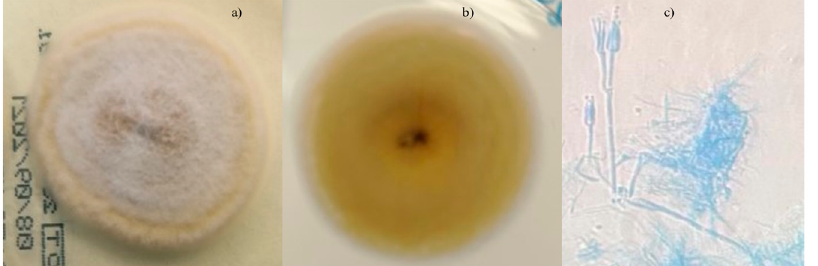
Figure 2. Microbiological assay images. ( a ) Front creamy colored; ( b ) reverse brown surface of Ge- osmithia argillacea mycelium; ( c ) microscopic lactophenol cotton blue stain; 400x. It can potentially be misidentified as other genera due to morphological similarities.